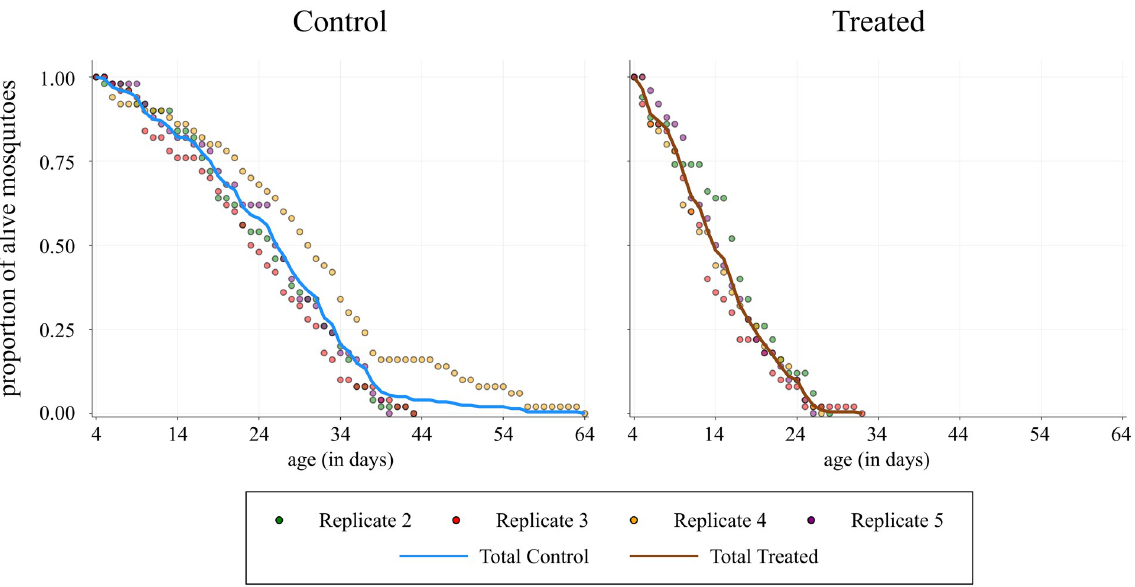
Fig 2. Proportion of alive mosquitoes. Visualisation of the data used for the calculations. The scatter plots show the proportion of alive mosquitoes at each time for 50 mosquitoes in each replicate, and the line shows the proportion of the total number of alive mosquitoes for 200 mosquitoes. Data are plotted up until the final remaining mosquito per replicate died. Replicate 1 was excluded for reasons outlined in the text.